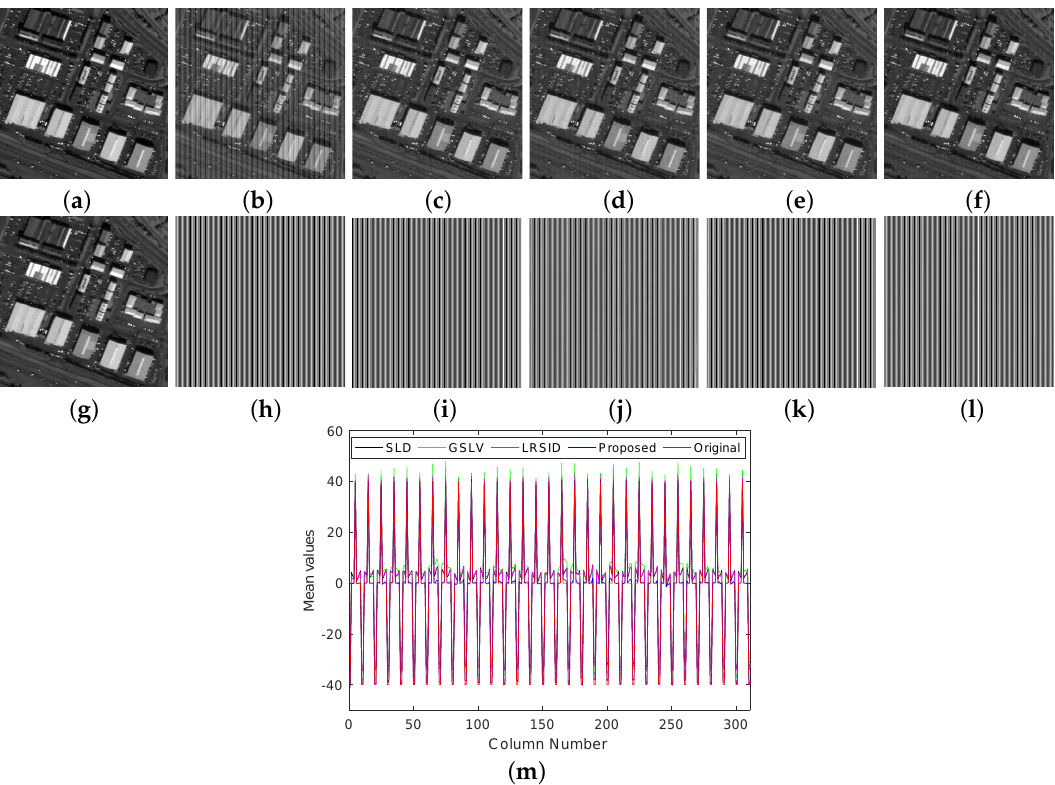
Figure 6. Destriping results with the simulated mixed noise case. ( a ) Original hyperspectral image; ( b ) degraded image with periodic stripes. Image component: ( c ) WAFT; ( d ) SLD; ( e ) GSLV; ( f ) LRSID; ( g ) the proposed method. Stripe component: ( h ) original added stripes; ( i ) SLD; ( j ) GSLV; ( k ) LRSID; ( l ) the proposed method; ( m ) mean value comparison between the stripes estimated by SLD, GSLV, LRSID, the proposed method, and the original one ( h